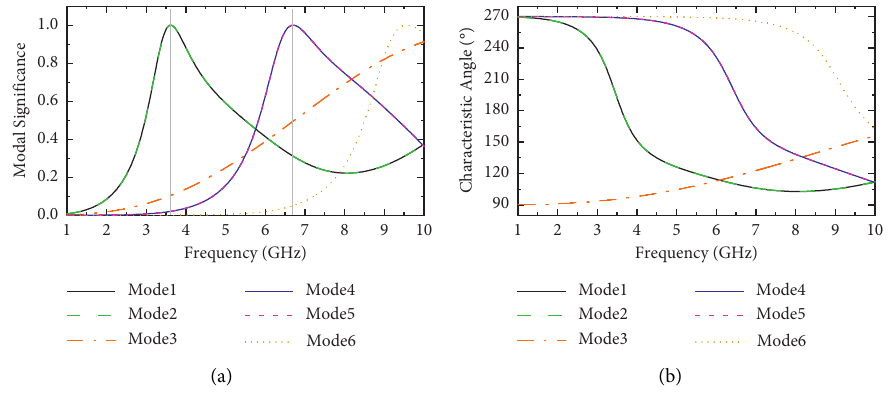
Figure 1: (a) Geometry of the ring patch: R A t � 5 ° , G p � 1, W p � 1. (Unit: mm).